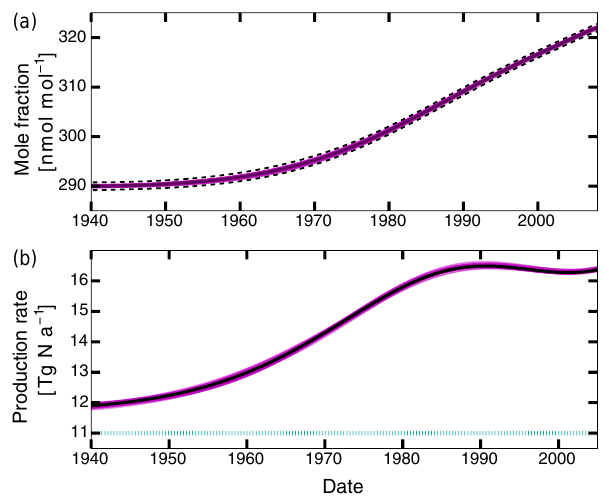
Figure 3. (a) N 2 O mole fraction history constrained with the most precise data at NEEM only to narrow the uncertainties (solid black line with uncertainty envelopes as dashed black lines) and the sce- narios within the uncertainty envelopes that were used in the mass balance model (magenta lines) to evaluate the uncertainties of the atmospheric modeling results. (b) N 2 O production rate as calcu- lated from the mass balance model. The solid black line represents the result for the best-fit reconstruction, while magenta lines rep- resent the results for the individual scenarios from (a) . The dotted light green line denotes the natural source emissions which were kept constant in our model